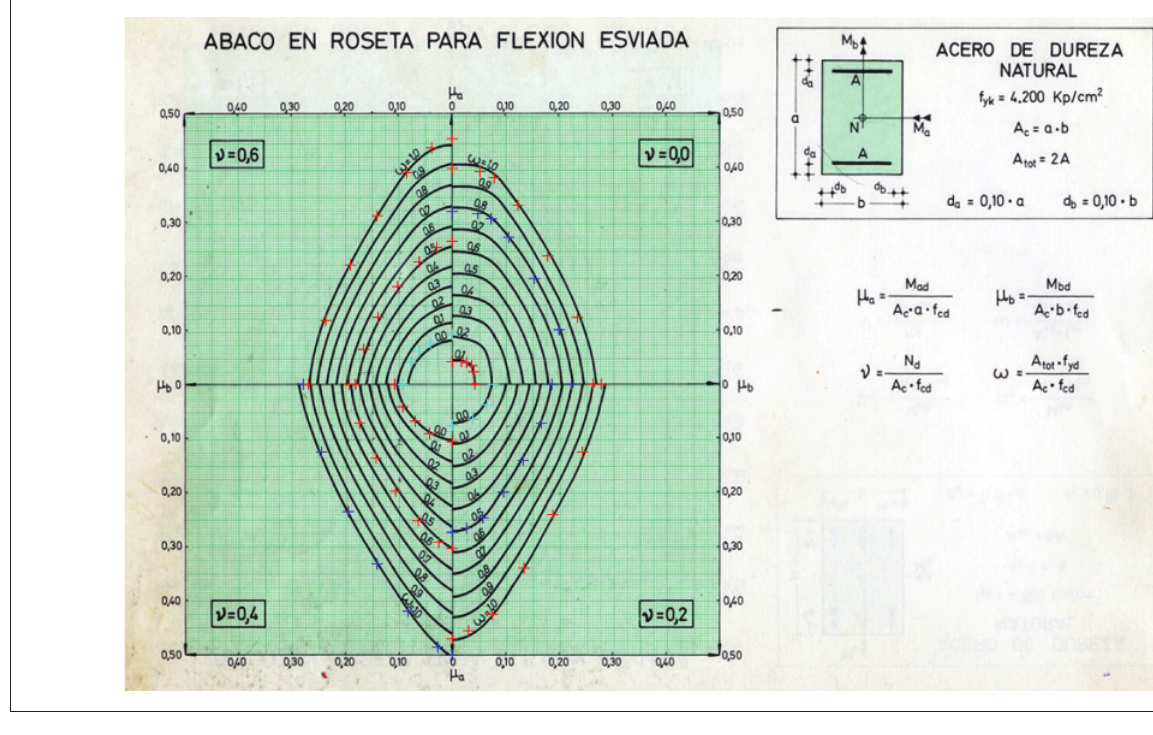
Figure 12 – Designed cross-section from the IBRACON [6]